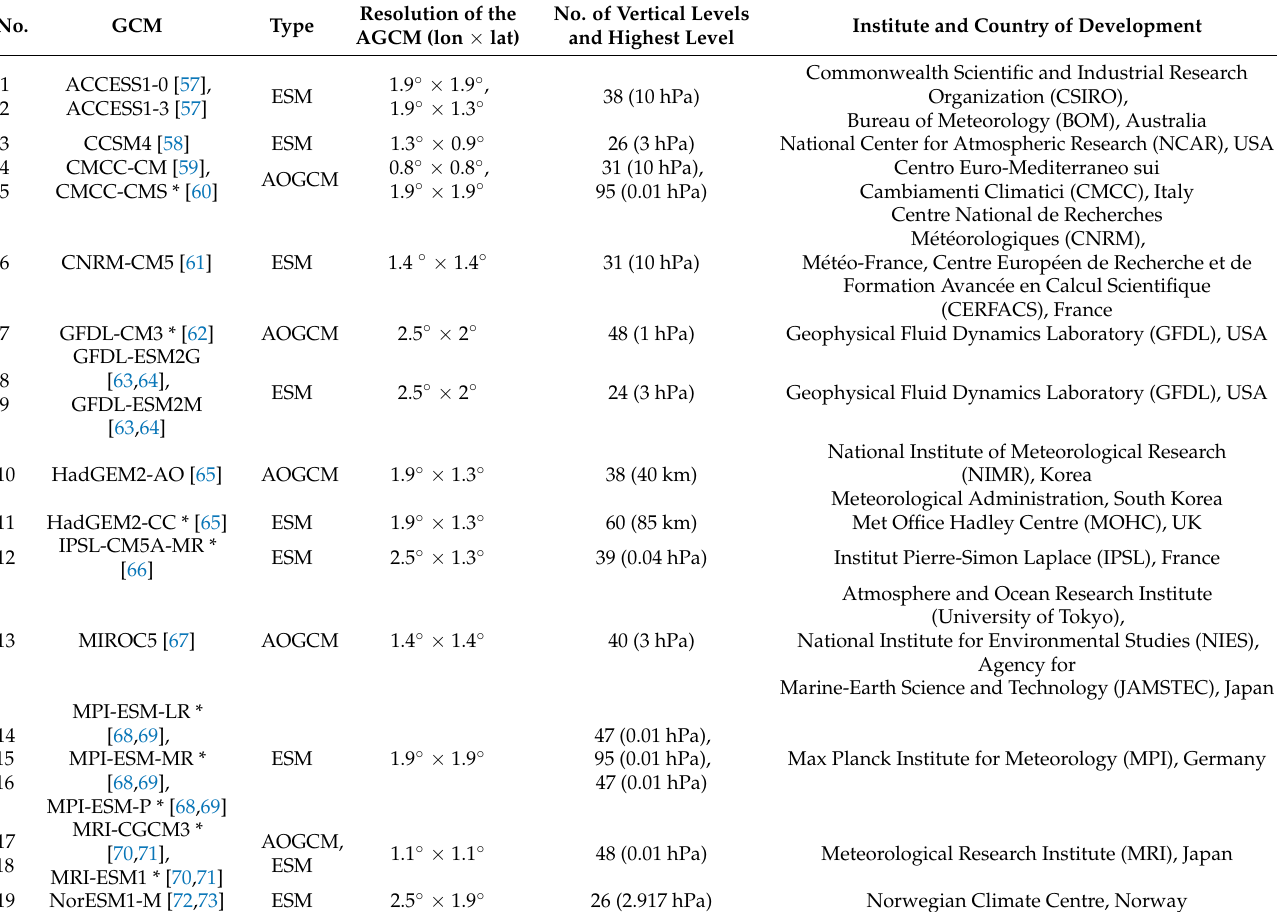
Table 1. List of the GCMs included in the study, including the horizontal resolution of their atmospheric GCM (AGCM). Experiment r1i1p1 is used, except for CCSM4, where r6i1p1 is available. GCMs with a well-resolved stratosphere are denoted with asterisk